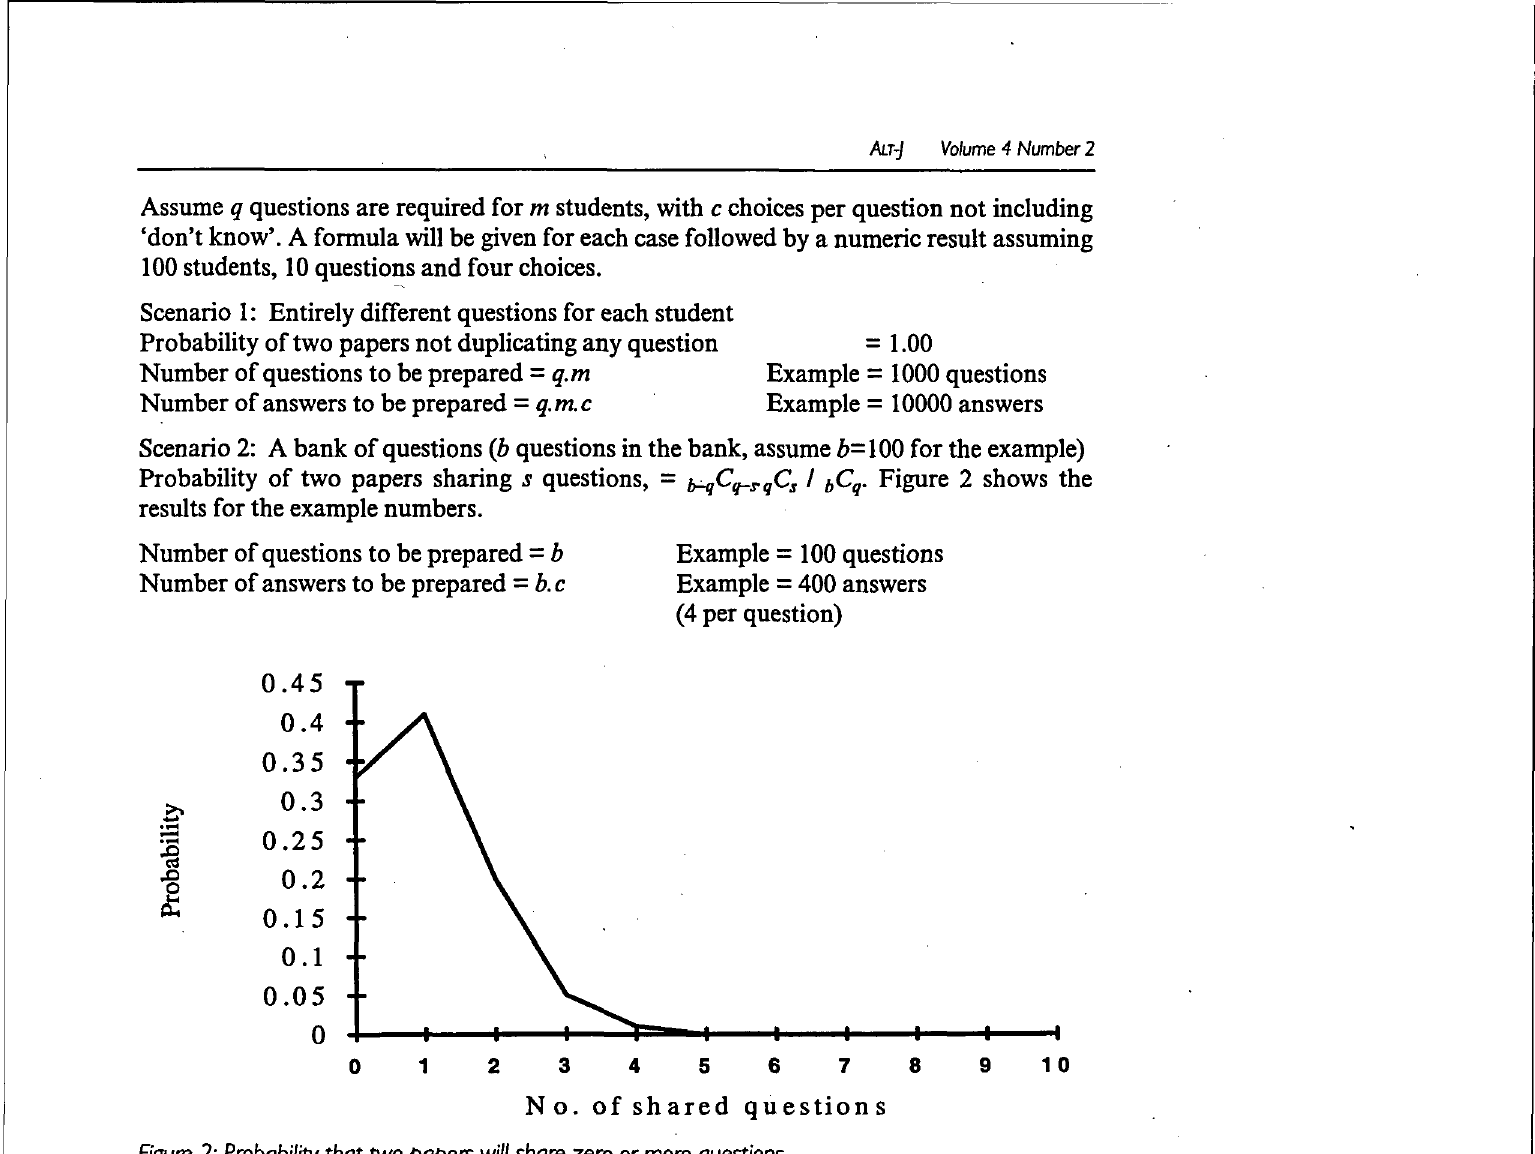
figure 2: Probability that two papers will share zero or more